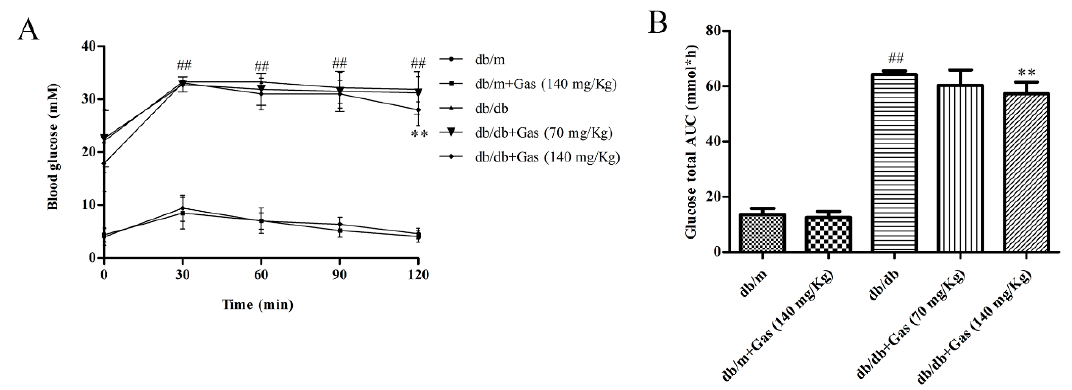
Figure 4. Effects of Gas on insulin resistance of db/db mice. ( A ) Curve of blood glucose level in OGTT. ( B ) Glucose total AUC in OGTT. ## p < 0.01, compared with the db/m group. ** p < 0.01, compared with the db/db group.